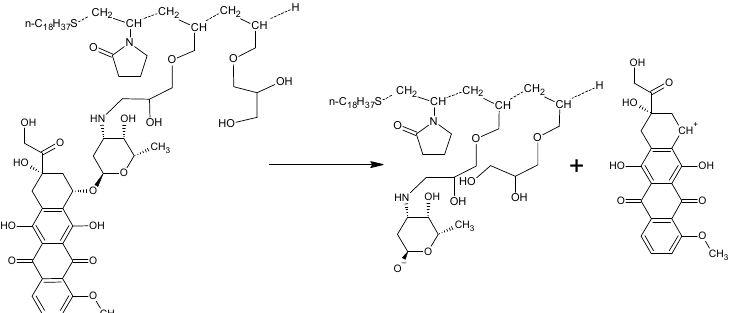
Figure 9. MALDI spectrum of an amphiphilic copolymer of N-vinyl-2-pyrrolidone and allyl glycidyl ether containing immobilized doxorubicin.